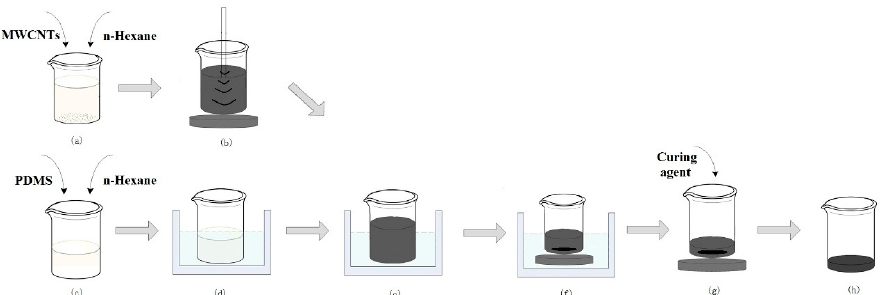
Figure 1. Preparation process flow of the multi-wall carbon nanotube (MWCNT)/polydimethylsiloxane (PDMS) composite. ( a ) MWCNTs and n-Hexane were mixed in a mass ratio of 1:200. ( b ) MWCNTs were dispersed in n-Hexane through tip sonication. ( c ) PDMS and n-Hexane were mixed in a mass ratio of 1:5. ( d ) PDMS was dispersed in n-Hexane through a bath sonicator. ( e ) The MWCNTs dispersion was added into the PDMS dispersion and processed continuously in the bath sonicator. ( f ) The mixture was placed in a water bath at 75 °C under magnetic stirring until the n-Hexane was totally volatilized. ( g ) The curing agent (mass ratio to PDMS 1:10) was added into the mixture made from MWCNT/PDMS and then magnetically stirred. ( h ) The homogeneous MWCNT/PDMS composite was ready for molding.